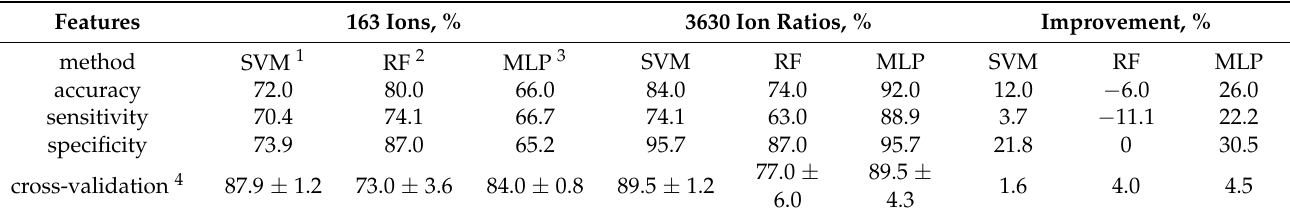
Table 3. The accuracy, sensitivity, specificity, and cross-validation of